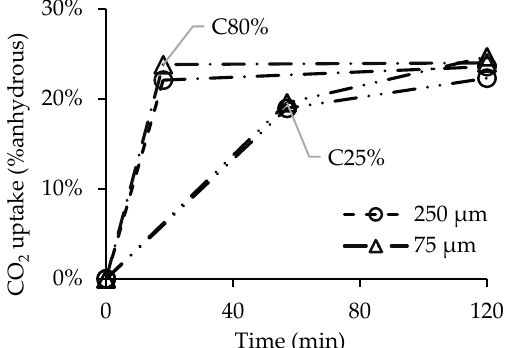
Figure 9. CO 2 uptake over time for different CPP particle sizes for CO 2 concentrations of 80% and 25%.